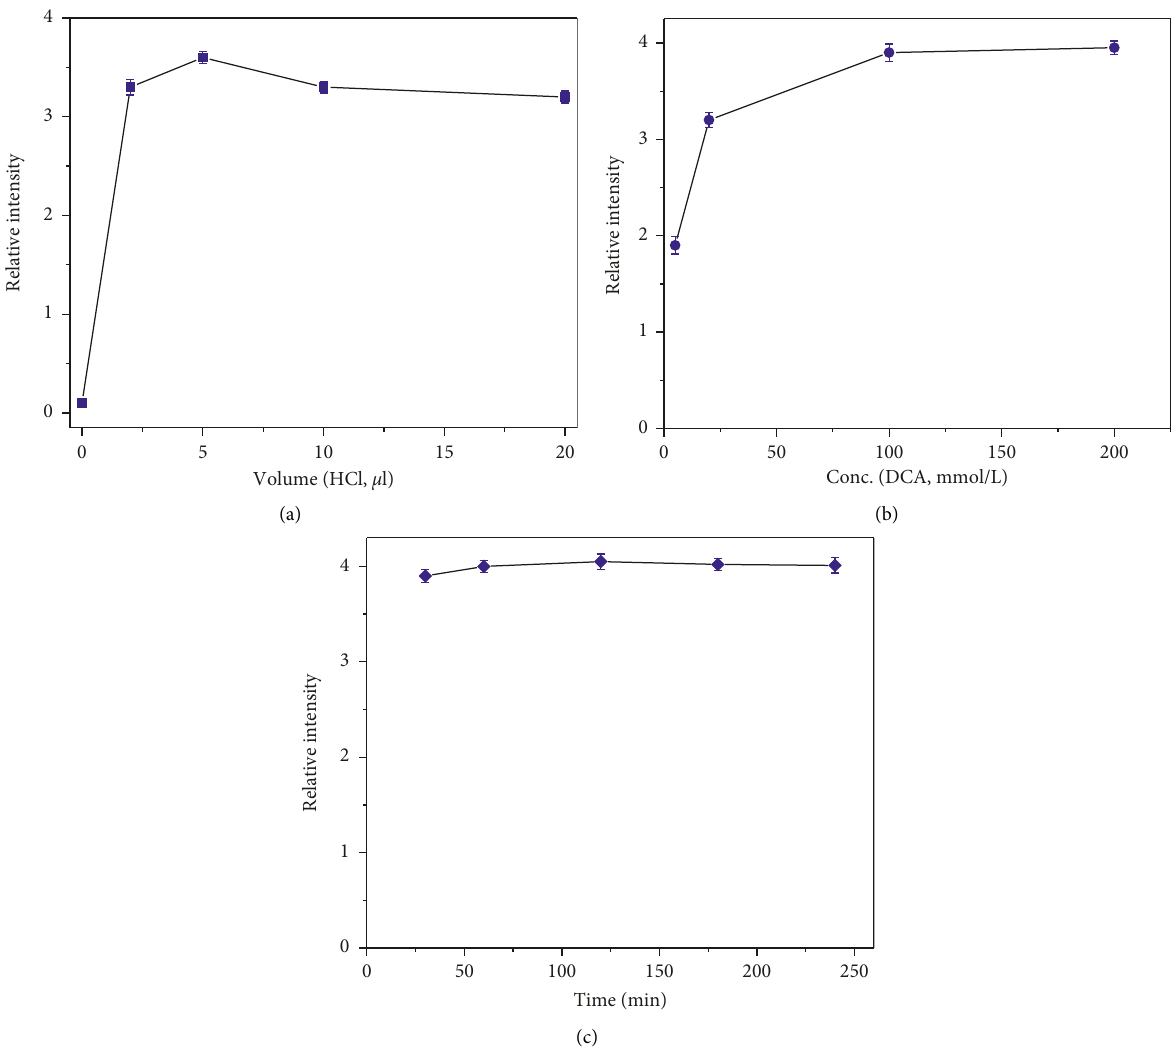
Figure 2: Derivatization optimization: effects of (a) HCl volume, (b) DCA concentration, and (c) reaction time on derivatization